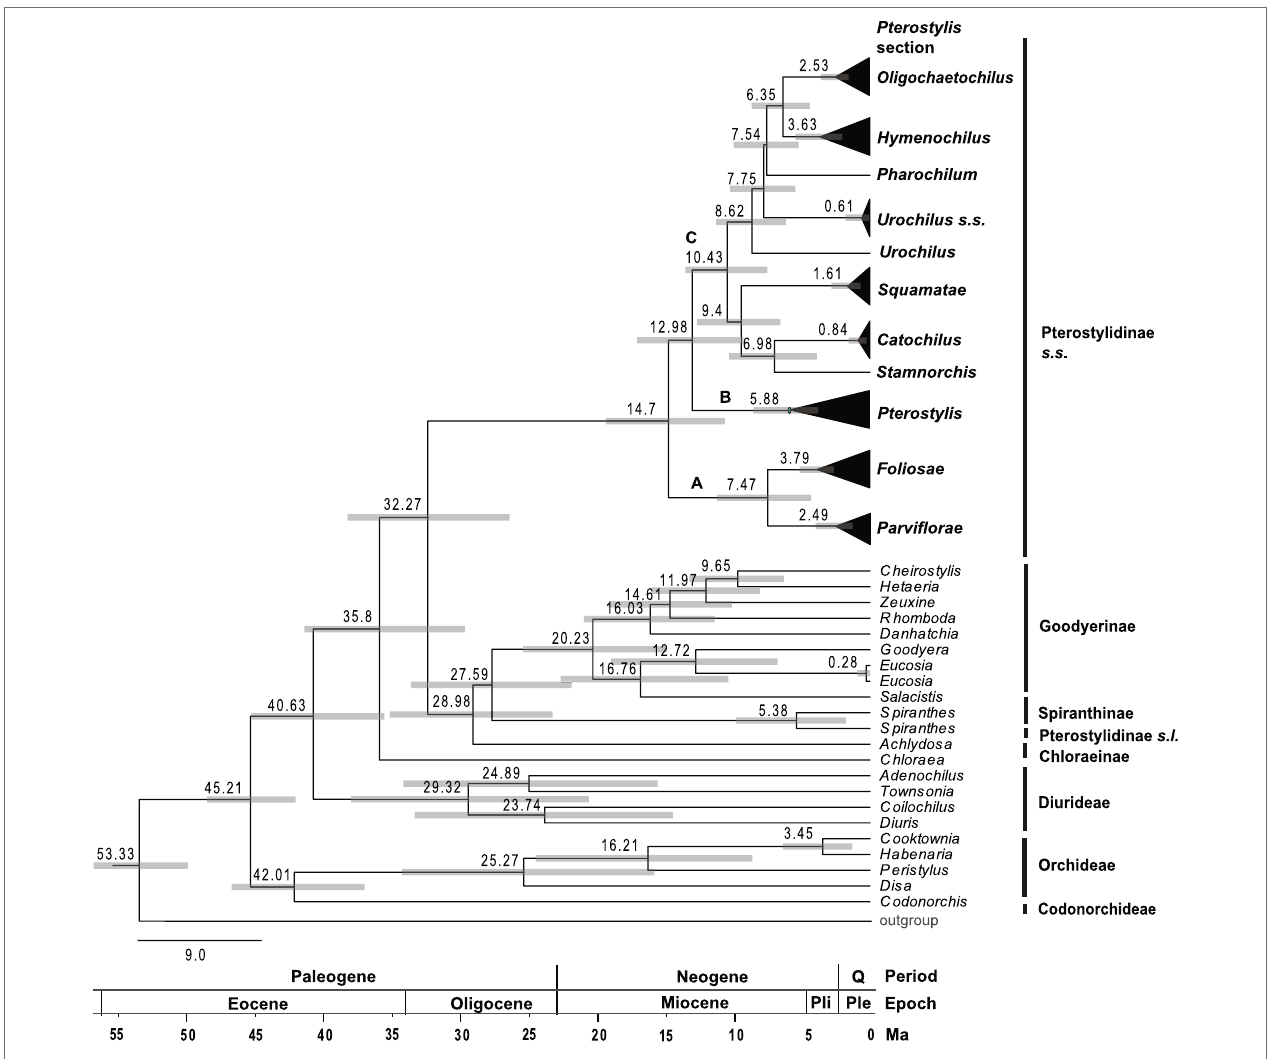
FIGURE 5 | Chronogram showing divergence times of main lineages within Pterostylidinae s.s. and of tribes in Orchidoideae. Maximum-clade credibility tree from Bayesian divergence-time estimation based on 25 most informative plastid genes and an uncorrelated molecular clock model under the birth–death tree prior. Divergence times (Ma) are given at each node together with 95% highest posterior density (HDP) values indicated by grey bars. The full chronogram is provided in Supplementary Material S3